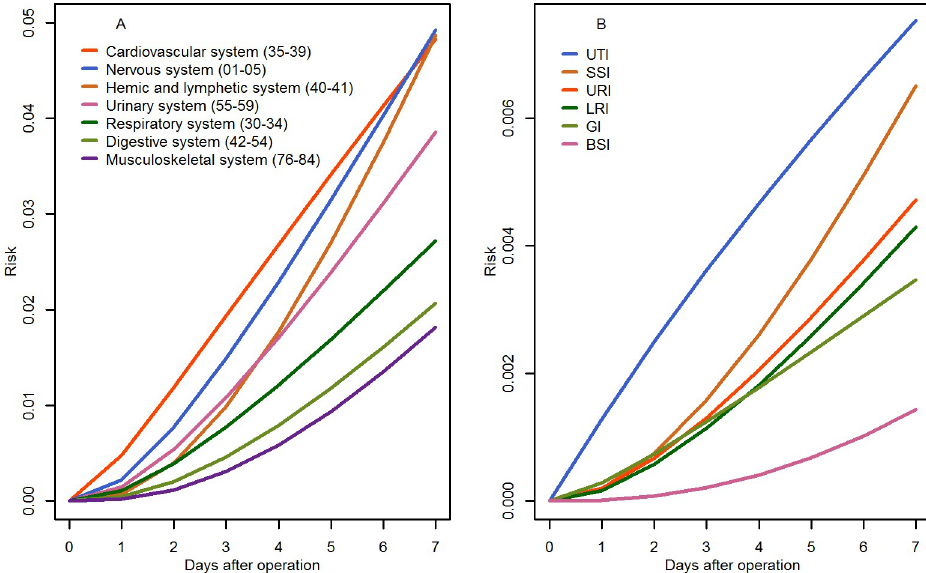
Fig 1. Risk of developing NIs in the first postoperative week, stratified by operative site (plot A) and by infection site (plot B). BSI (bloodstream infection), GI (gastrointestinal infection), LRI (lower respiratory tract infection), NI (nosocomial infection), SSI (surgical site infection), URI (upper respiratory tract infection, (UTI) urinary tract infection.